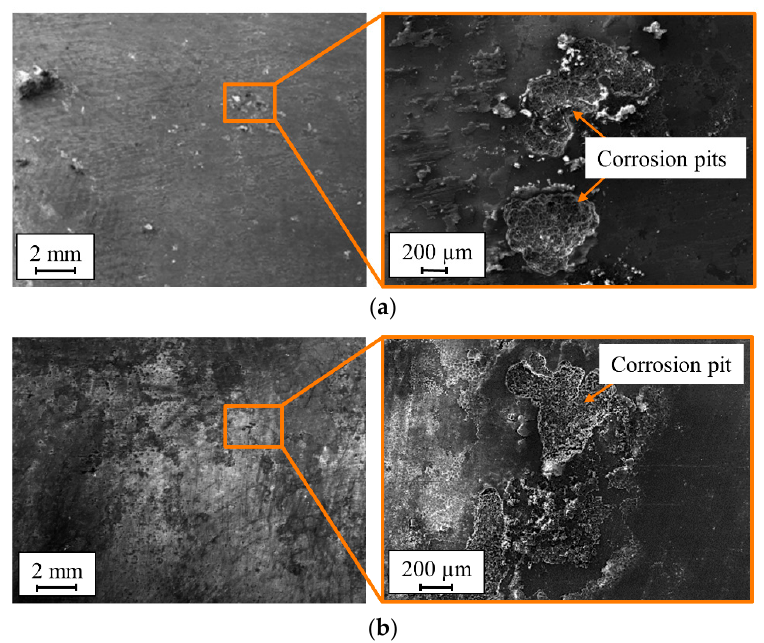
Figure 18. SEM images of EN AW-5754 specimens after ( a ) the salt spray test and ( b ) cyclic climate change tests.